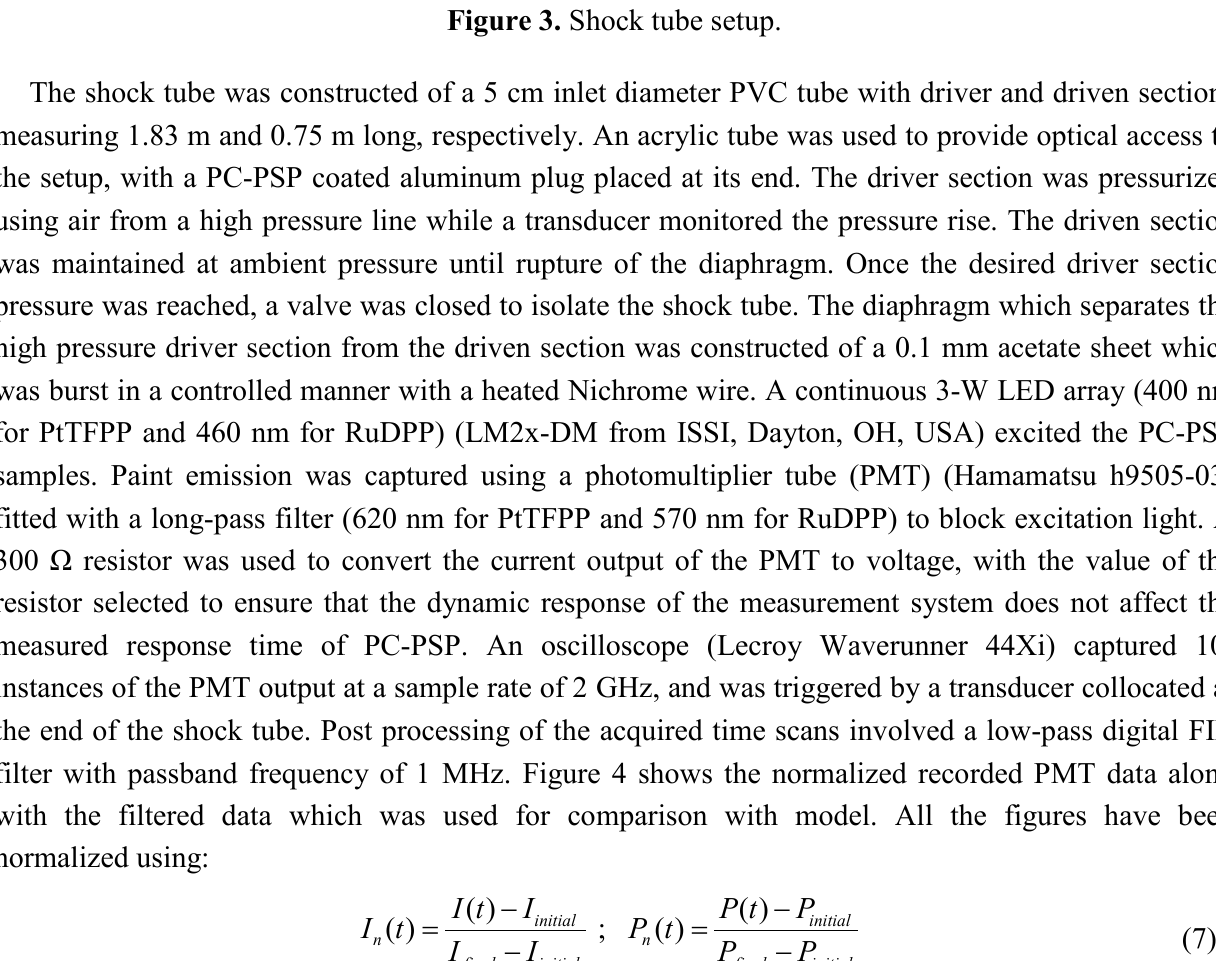
Figure 3. Shock tube